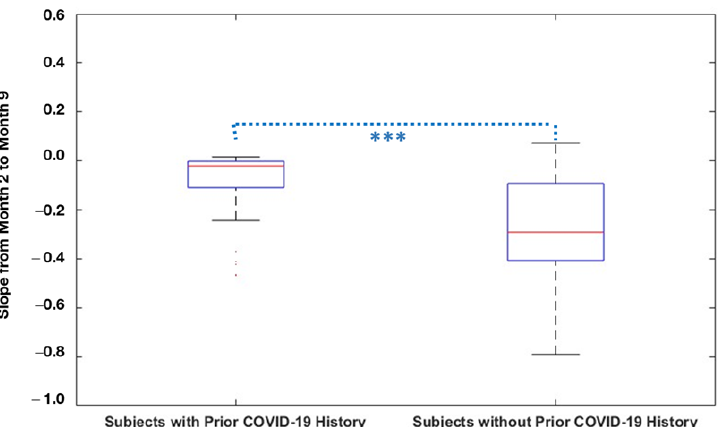
Figure 2. Antibody Decay Slope per baseline COVID infection history. Slopes in antibody levels from Month 2 through Month 9 were compared between subjects with COVID-19 history before vaccination (n = 46), and without COVID-19 history prior to vaccination (n = 249). The slope of antibody decline over time was significantly steeper in the subjects without a history of pre-vaccination COVID-19 infection. *** p < 0.001. Table 2. Slope Decline Categories Amongst Non-Breakthrough Infection